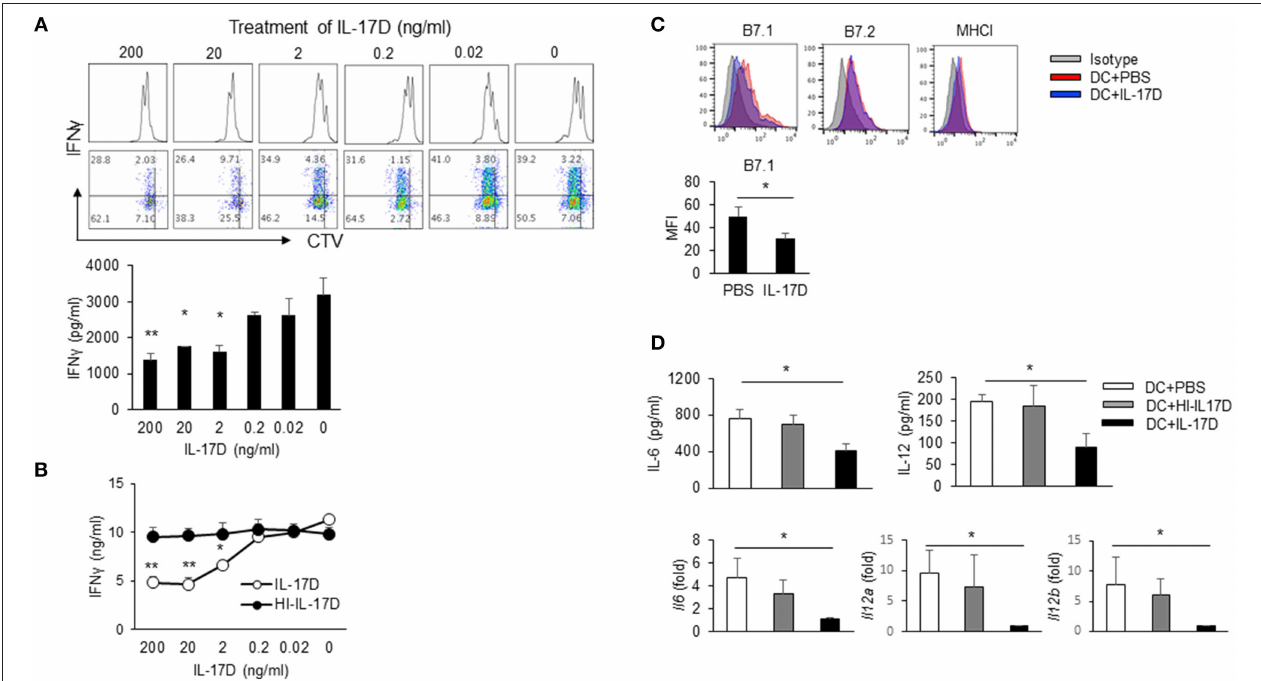
FIGURE 6 | IL-17D regulates CD8T cell proliferation by DC suppression. (A) DCs from LM-OVA-infected WT mice were pulsed with soluble OVA (20 µ g/ml). CTV-labeled OTI CD8T cells were co-cultured with DCs and IL-17D (200-0ng/ml) for 3 days. Production of IFN γ was analyzed by intracellular staining and ELISA. (B) OT-I cells were co-cultured with DCs and IL-17D or heat-inactivated IL-17D (200-0ng/ml) for 3 days, and IFN γ production was measured by ELISA. (C,D) DCs were isolated from LM-OVA-infected mice and treated with IL-17D (200ng/ml) for 1 day. DC activation markers (CD80, CD86, and MHC I) were analyzed by flow cytometry. Cytokines (IL-6 and IL-12) were analyzed by ELISA and RT-PCR. Data are representative of three independent experiments. * p ≤ 0.05, ** p ≤